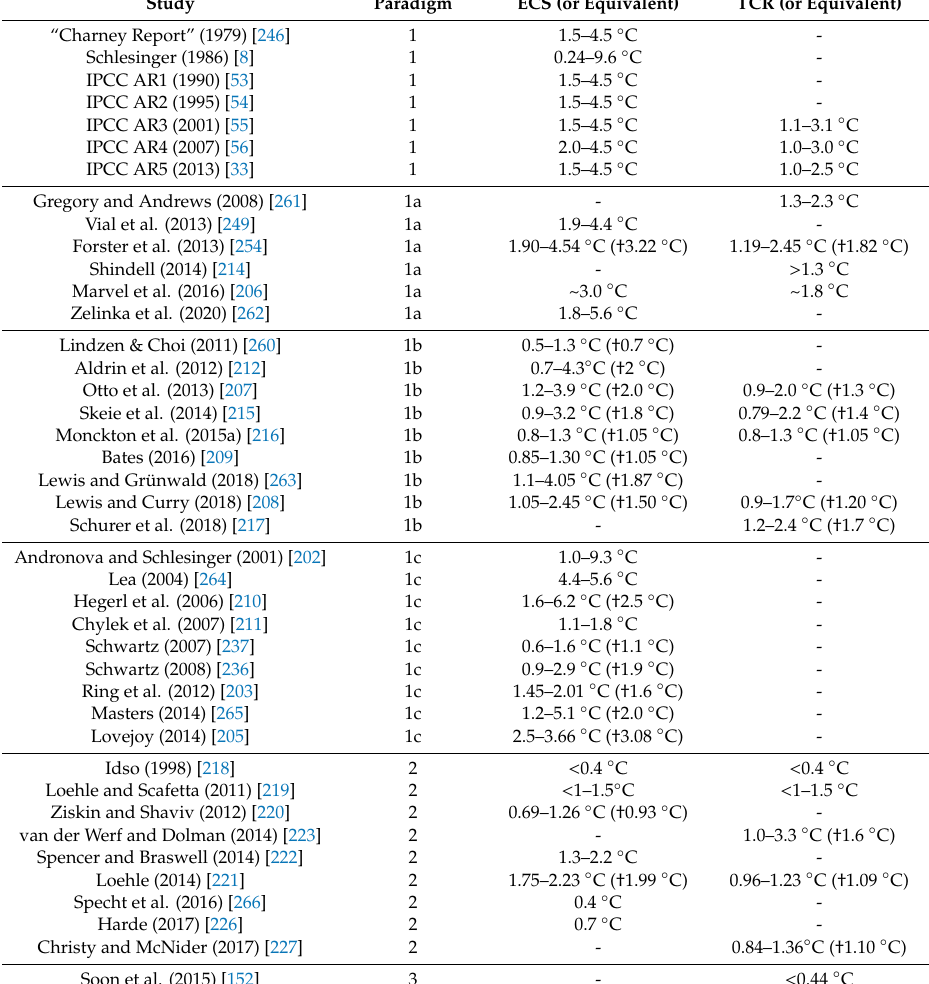
Table 5. Various di ff erent estimates of the climate sensitivity, i.e., expected human-caused global warming from a doubling of atmospheric CO 2 , in terms of either Equilibrium Climate Sensitivity (ECS) or Transient Climate Response (TCR). The estimates are in no way meant as comprehensive (see Knutti et al. 2018 [200] for a summary of several hundred estimates in the literature), but are rather an illustrative sample of typical values in the literature, with examples taken from each of the paradigms described in the text. The values accompanied by a † correspond to the most-likely, mean, or median value if provided by the